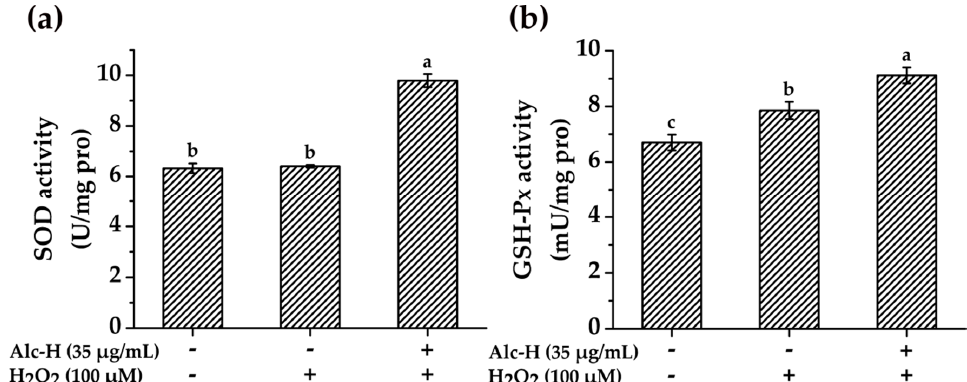
Figure 5. Effects of alcalase hydrolysate (Alc-H) on the activities of antioxidant enzymes in PC12 cells. ( a ) SOD activity; ( b ) GSH-Px activity. PC12 cells were pretreated with Alc-H (35 μ g/mL) for 12 h before being exposed to 100 μ M H 2 O 2 for 1 h. Data are expressed as mean ± SD ( n = 4). Bars with different alphabets indicate statistically significant difference between the means ( p < 0.05).